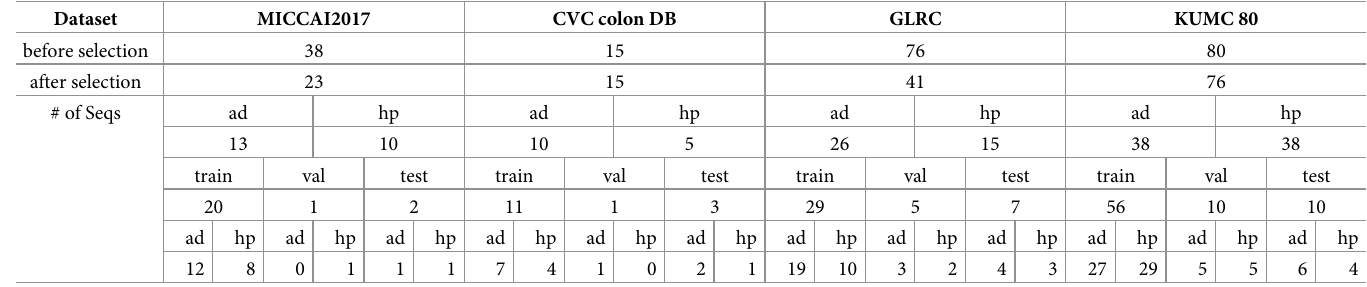
Using the generated dataset, we evaluated eight state-of-the-art object detection models, including Faster RCNN [52], YOLOv3 [56], SSD [64], RetinaNet [65], DetNet [66], RefineDet [68], YOLOv4 [59] and ATSS [69]. To set the benchmark performance, three different experi- ment setups are tested: frame-based two-class polyps detection , frame-based one-class polyps detection , and sequence-based two-class polyps classification . The performance of the two frame-based detections is measured using regular object detection metrics. For the sequence-based classification, regular detection models will be applied to each frame. Then a Table 1. Dataset